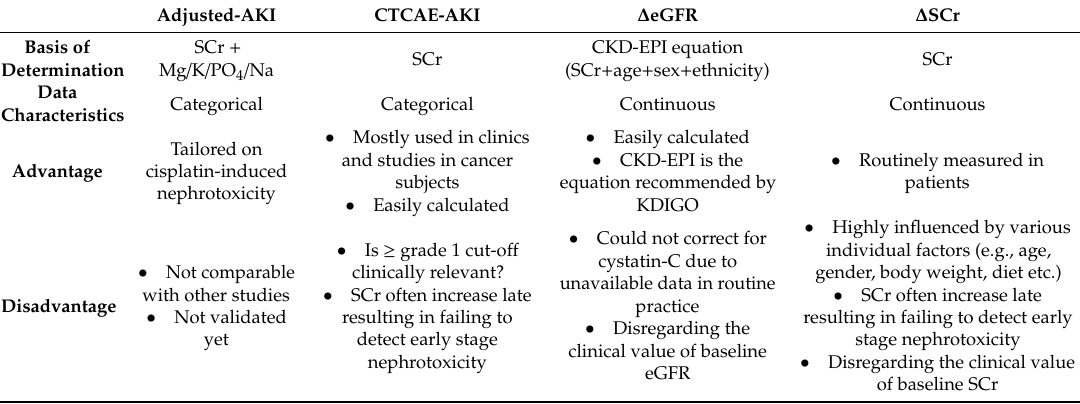
Table 10. Multiple outcome definitions of cisplatin-induced nephrotoxicity used in this study. Adjusted-AKI CTCAE-AKI ∆ SCr Basis of SCr Determination